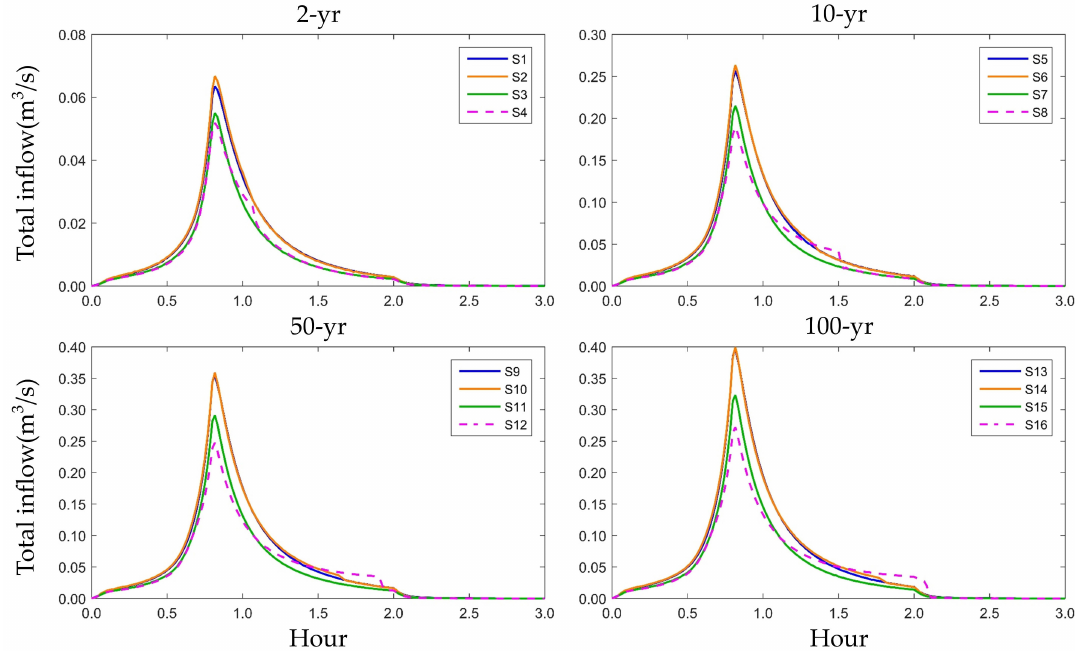
Figure 12. Total inflow hydrographs of outfall 4Y455 in the convention district for the 16